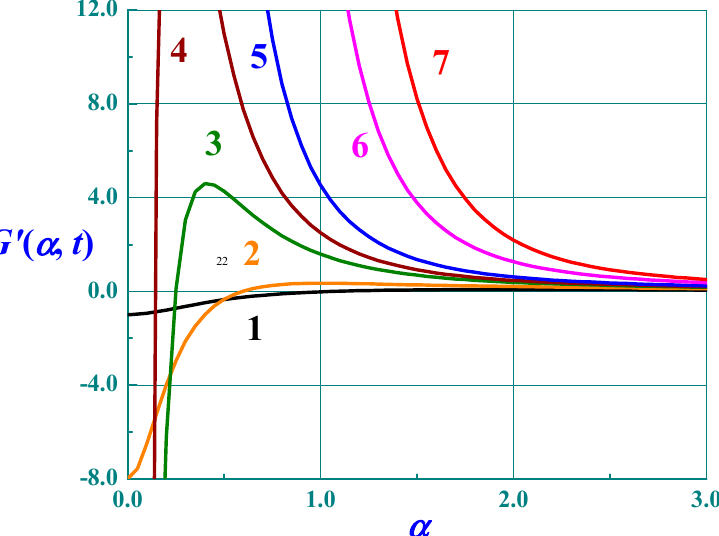
Figure 3. G’ ( α , t )—Second derivatives of the Mittag-Leffler functions with respect to α plotted at constant values of t . 1—0.25; 2—0.50; 3—0.75; 4—0.85; 5—1.0; 6—1.5; 7—2.0.